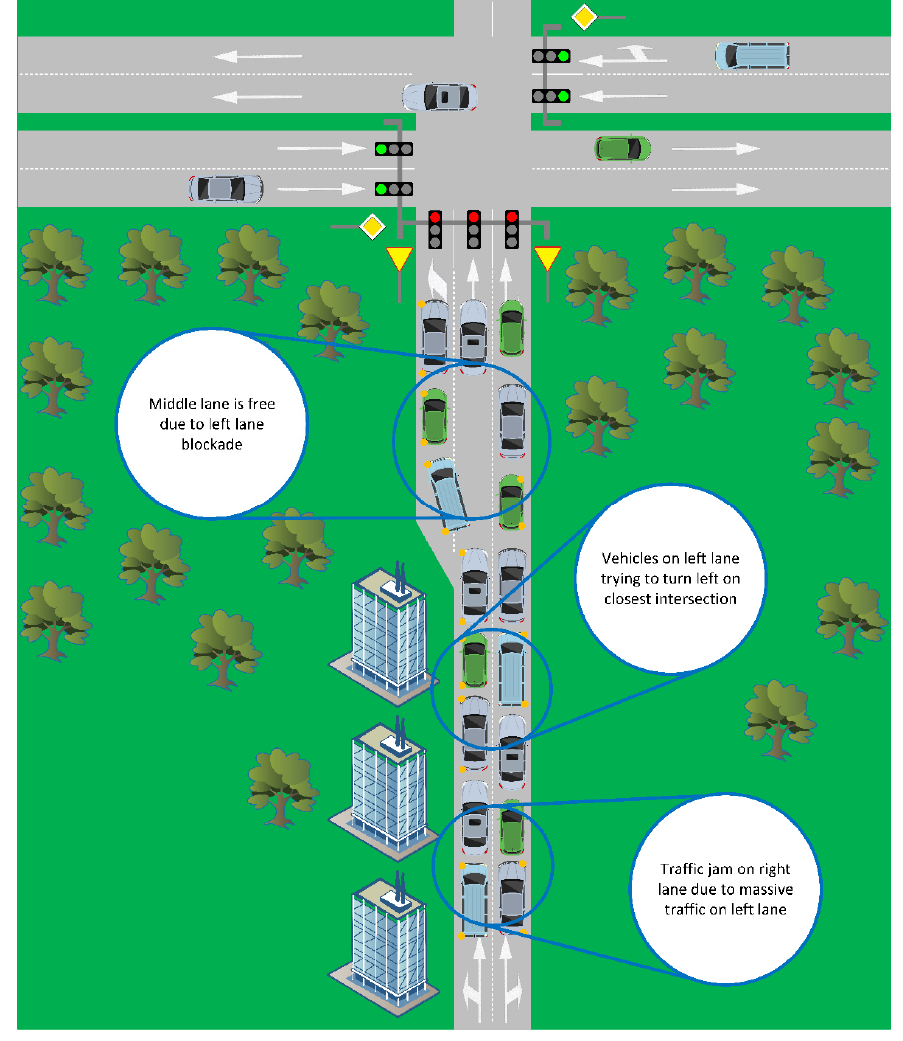
Figure 3. A traffic jam when vehicles line up in different directional lanes.